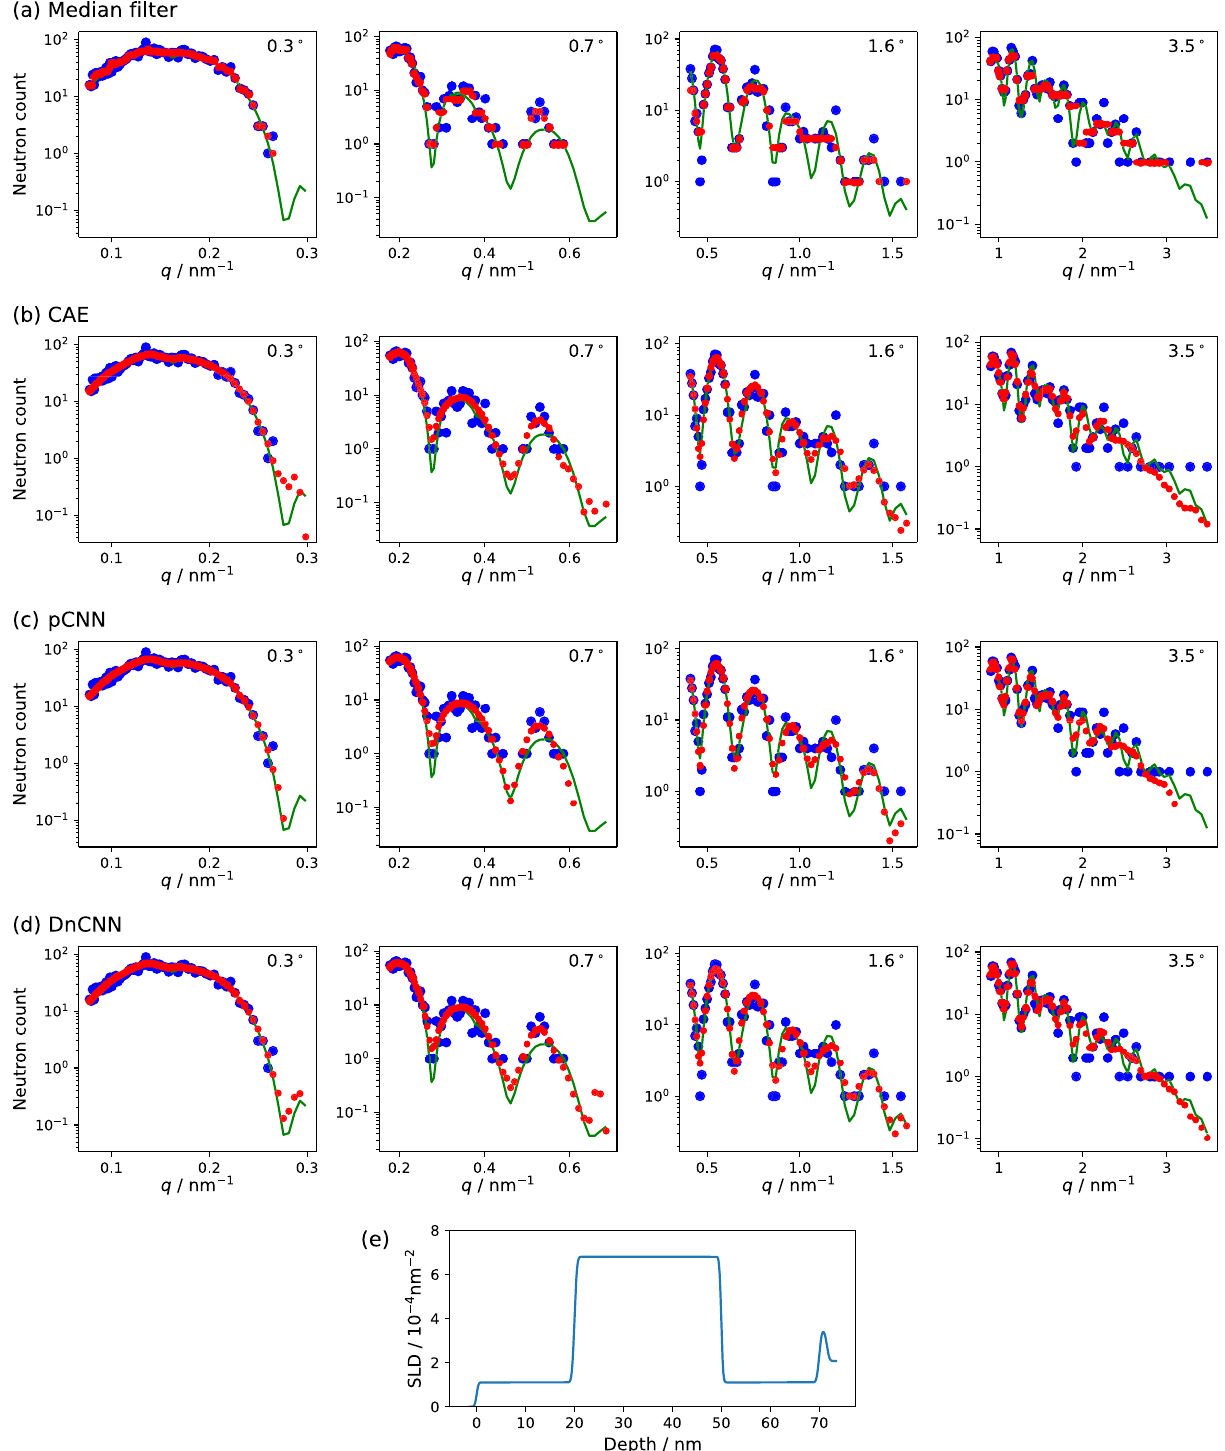
Figure 3. Predicted NR intensity profiles (red circles) by median filter ( a ), CAE ( b ), pCNN ( c ), and DnCNN ( d ) from the data with 5% neutron counts of the standard condition for the SLD distribution shown in ( e ). The green curves and blue circles represent the ground truth and simulated data,